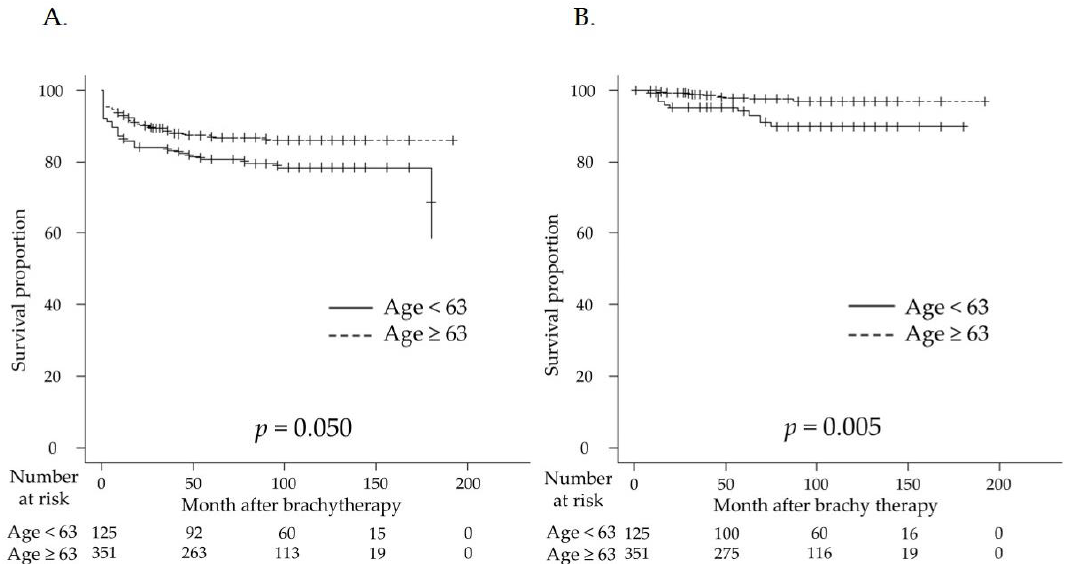
Figure 2. Kaplan–Meier estimates of biochemical recurrence-free survival (BRFS) in patients with prostate cancer who received low-dose-rate brachytherapy were calculated according to patient age. ( A ) With the RP definition, the 5-year BRFS rates were 80.6% in the group aged <63 years and 86.6% in those aged ≥63 years. The biochemical recurrence rate (BCR) tended to be higher in the population aged <63 years than in those aged ≥63 years ( p = 0.050). ( B ) With the J-POPS definition, the 5-year BRFS rates in the groups aged <63 years and ≥63 years were 94.1% and 97.8%, respectively. The BCR rate was significantly higher in the population aged <63 years than in those aged ≥63 years ( p = 0.005).